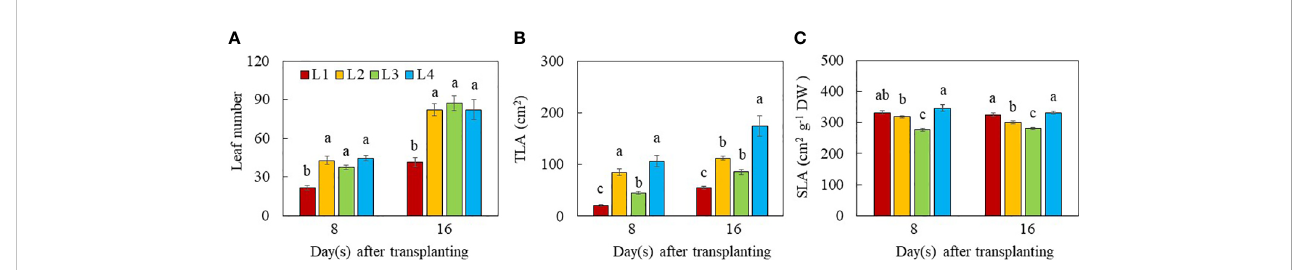
FIGURE 4 Leaf number (A) , TLA (B) and SLA (C) of purslane grown under different light conditions for 8 and 16 days. Values are means ± standard errors. Means with different letters are statistically different ( p <0.05; n =5) as determined by Tukey ’ s multiple comparison test for each day. Refer to Figure 1 for the different conditions of L1, L2, L3 and